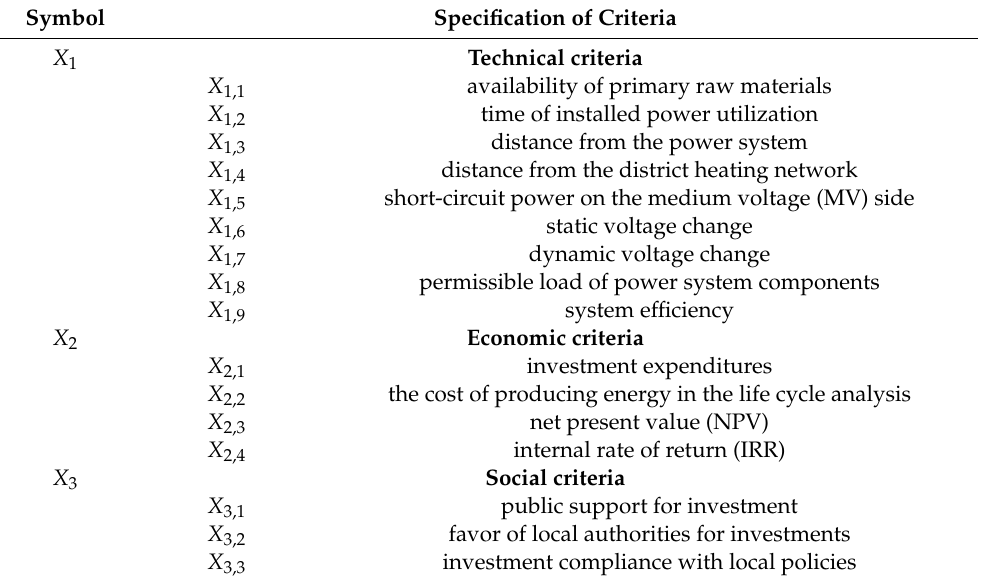
Table 1. A universal set of criteria used to assess the location of electricity generation